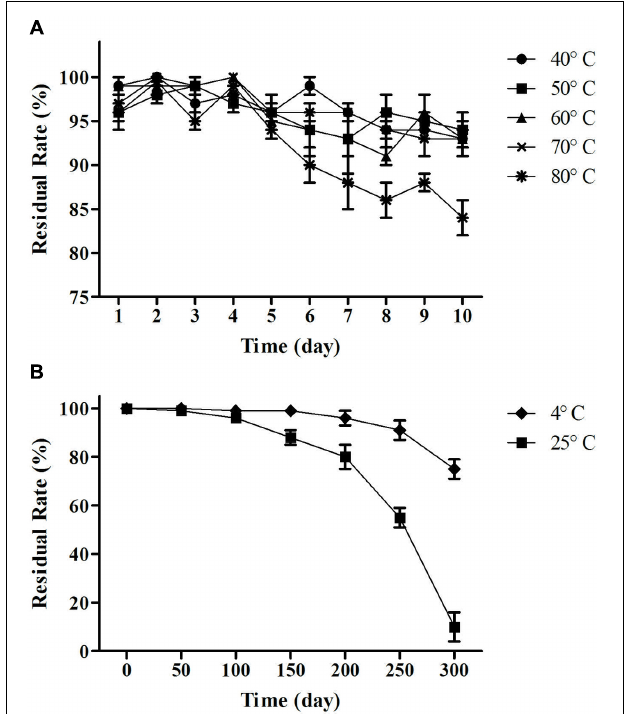
FIGURE 7 | Temperature stability test. (A) Residual rate of change over time at 40, 50, 60, 70, and 80 ◦ C. (B) Residual rate of change over time at 4 ◦ C (cold storage) and 25 ◦ C (room temperature). Residual rate remained above 90% between 40 and 70 ◦ C and 85% at 80 ◦ C after 10 days. The lipopeptides had reserved more than 80% of activities after storage at 4 ◦ C for 300 days. The residual rate decreased to 59% after storage at 25 ◦ C for 250 days.